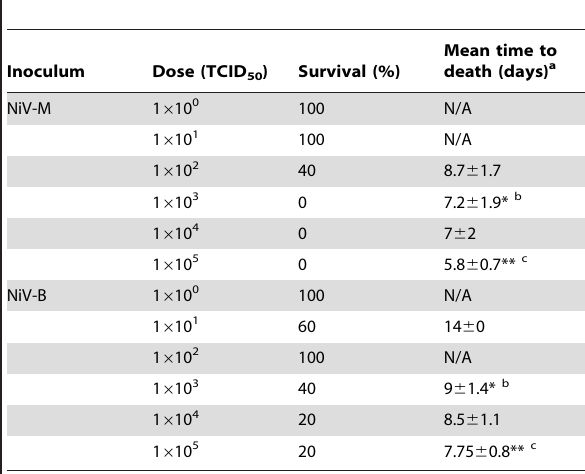
Table 1. Clinical signs and outcome of hamsters inoculated with NiV-M or